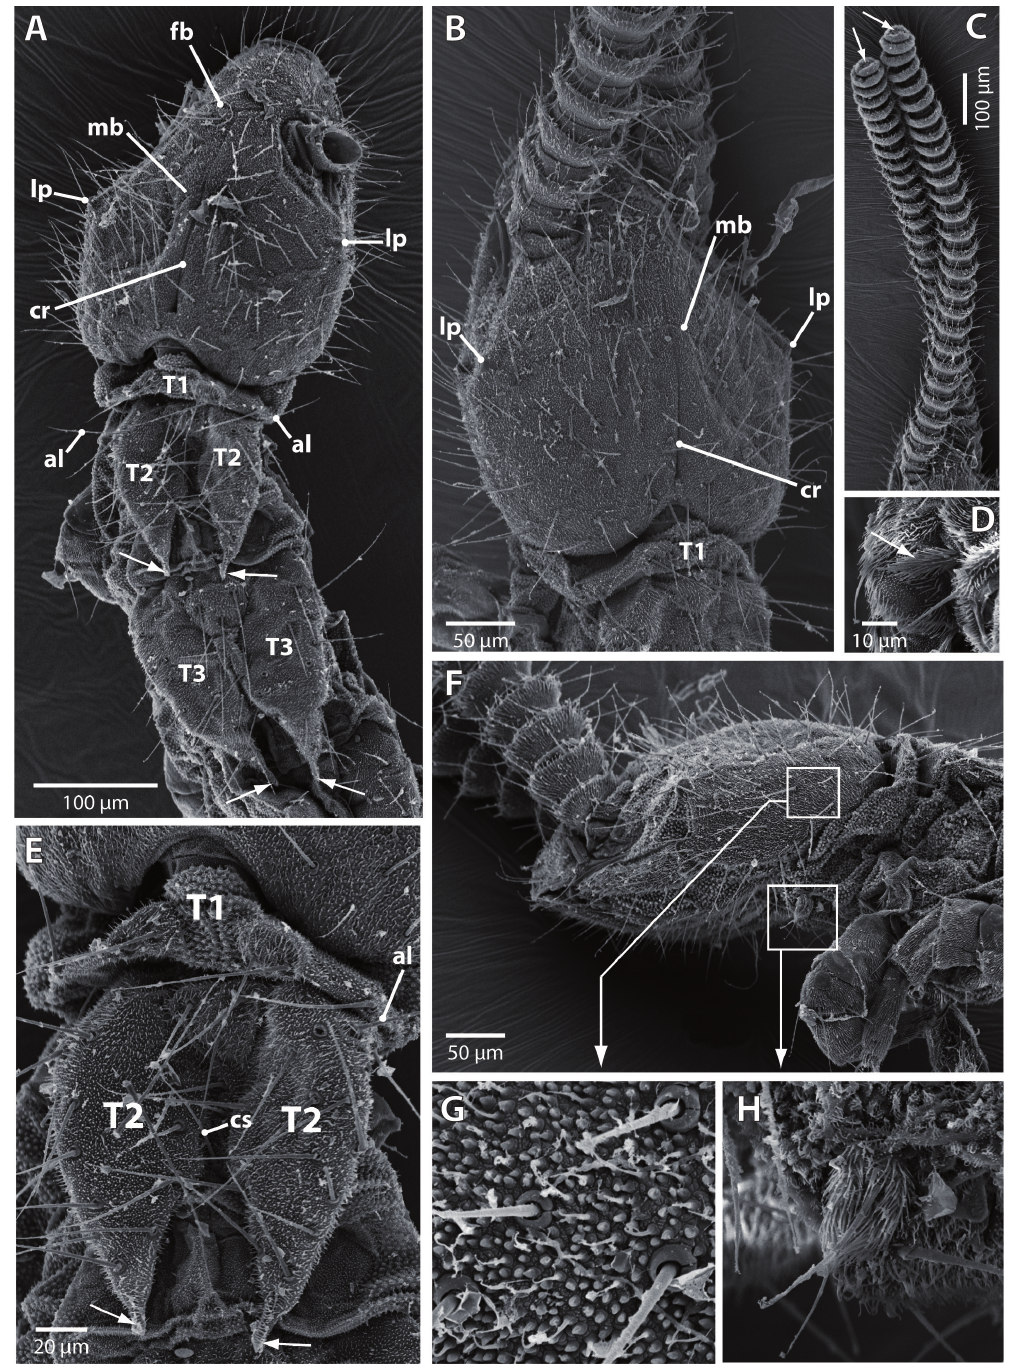
Fig. 9. Remysymphyla spinosa sp. nov. A . Head and first 3 tergites ( T1, T2, T3 ) of holotype, dorsal view. Arrows , digitiform end of triangular processes; al , anterolateral setae; cr , central rod; fb , frontal branches; lp , lateral protuberance of the head; mb , median branches. B . Head and first tergite ( T1 ) of paratype, dorsal view. Cr , central rod; lp , lateral protuberance of the head; mb , median branches. C . Antennae of paratype. Arrows , transversal depression of apical segments. D . Stylus of the leg 11 ( arrow ) of paratype. E . Detail of first ( T1 ) and second ( T2 ) tergites of holotype. Arrows , digitiform end of triangular processes; al , anterolateral seta; cs , central seta. F . Head and first legs of paratype, lateral view. G . Detail of the surface of the head of paratype. H . Detail of the first leg of